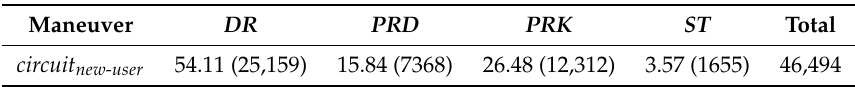
Table 18. Distribution of instances among the maneuvers of the circuit with the new driver in terms of the percentage and total number (in brackets).